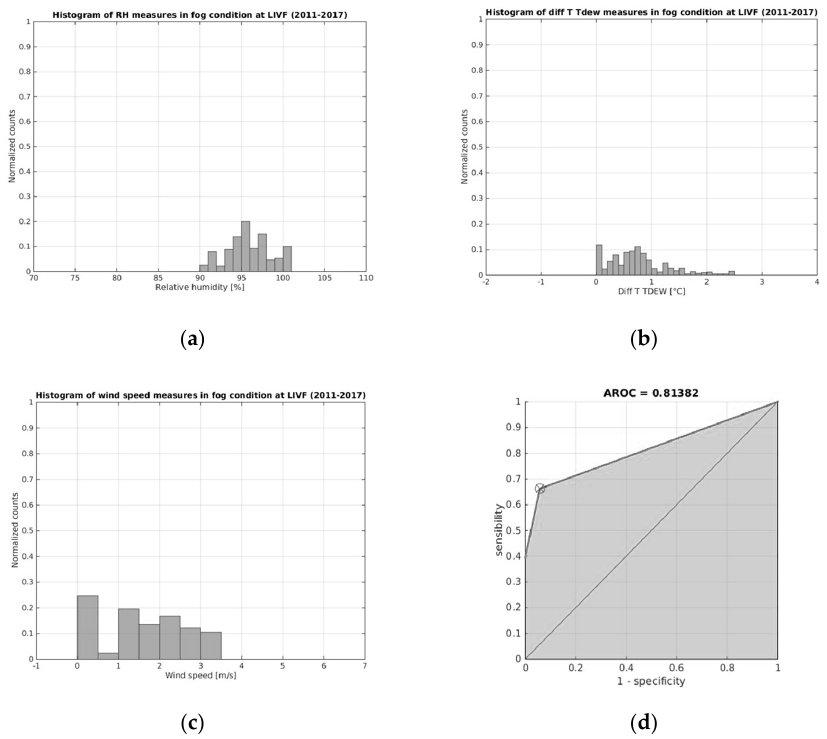
Figure 11. Histograms of the measurements of ( a ) relative humidity, ( b ) surface temperature/dew point difference, ( c ) wind speed in fog condition at Frontone in the period January 2011–December 2017 and ( d ) ROC curve obtained with FSI_thresh = 32.